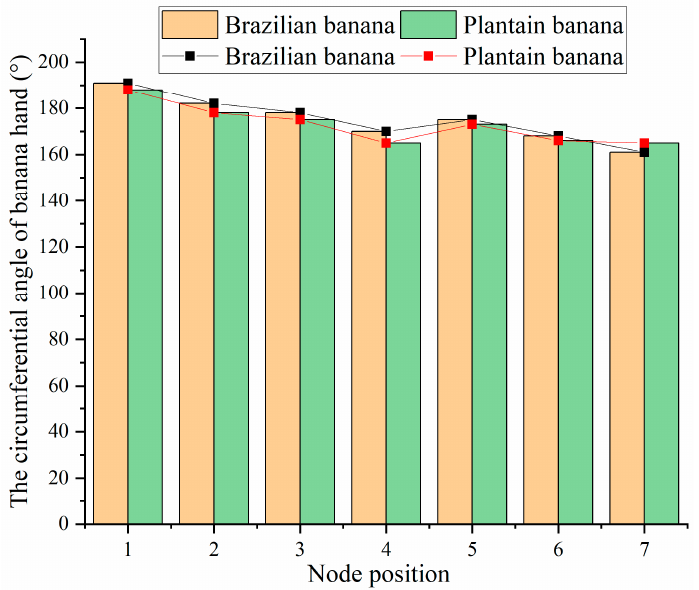
Figure 19. Measurement results of the circumferential angle of banana hands.